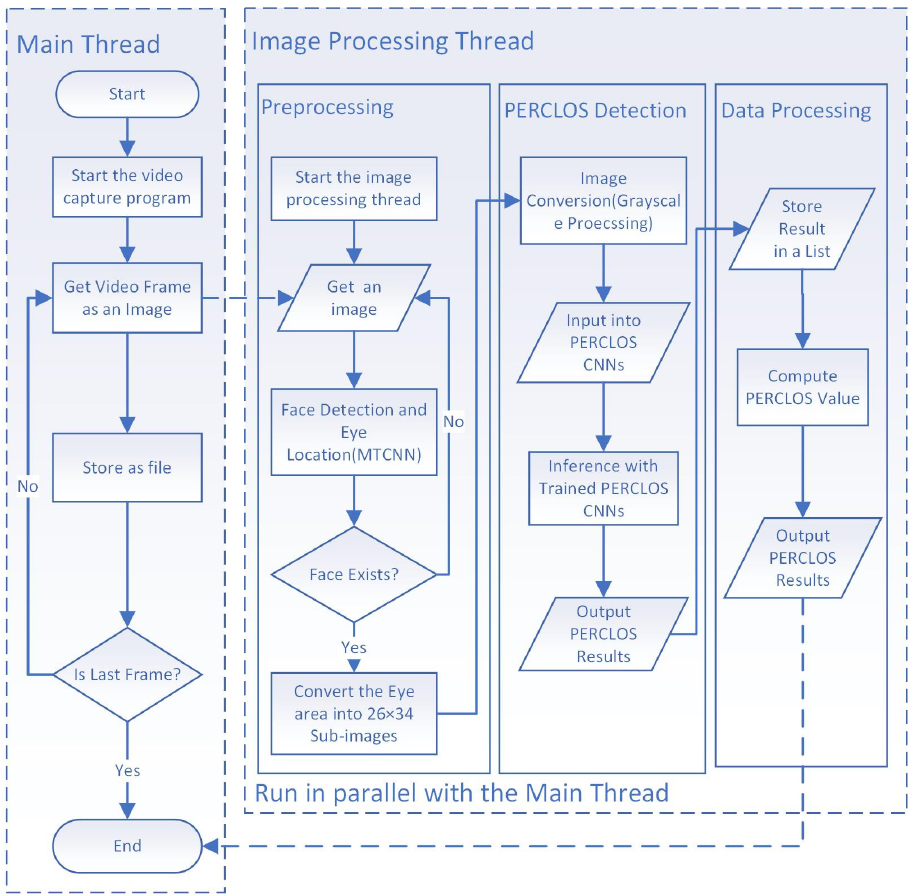
Figure 2. Process of video treatment for detecting air traffic controllers’ PERCLOS values .